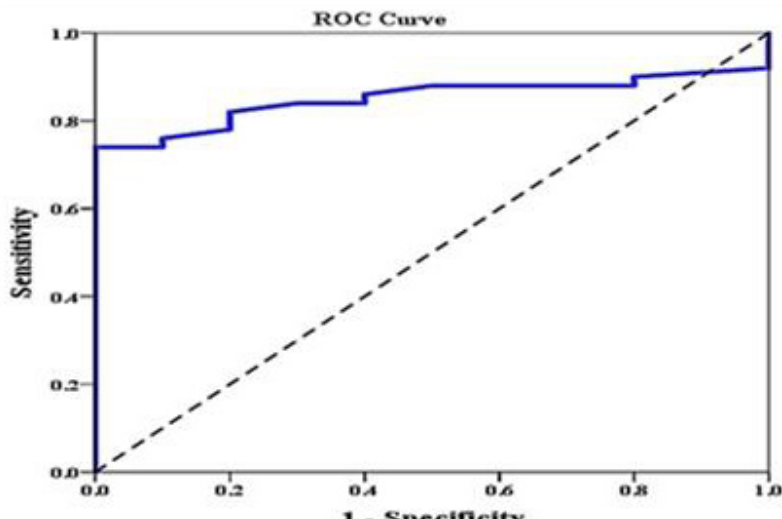
Figure 2. ROC curve analysis to explore the discriminant ability of pancreatic T2 in differentiating those with high liver iron concentration (LIC) (>7) from those with low LIC